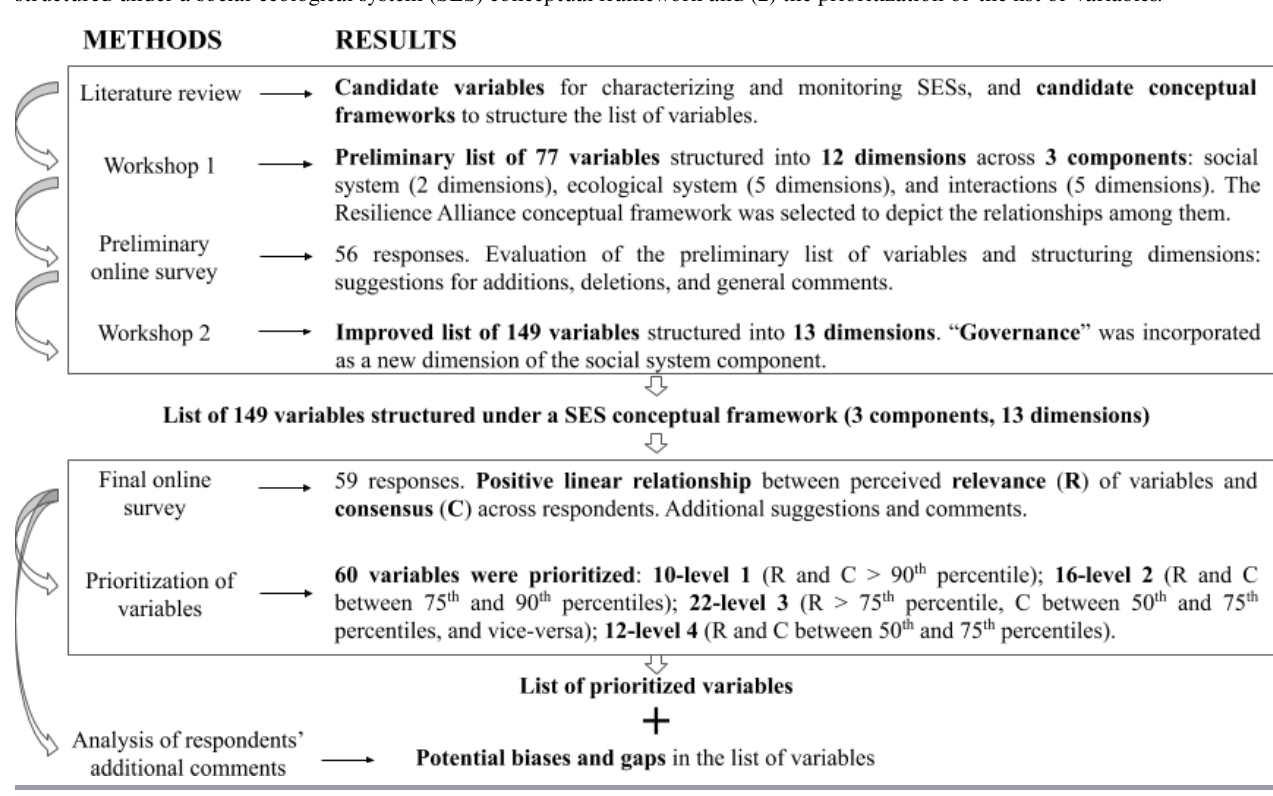
Fig. 1 . Workflow. The main methodological steps are identified on the left, and their respective results are on the right. The boxes group together the methodological steps to indicate the two main stages of this study: (1) the development of a list of